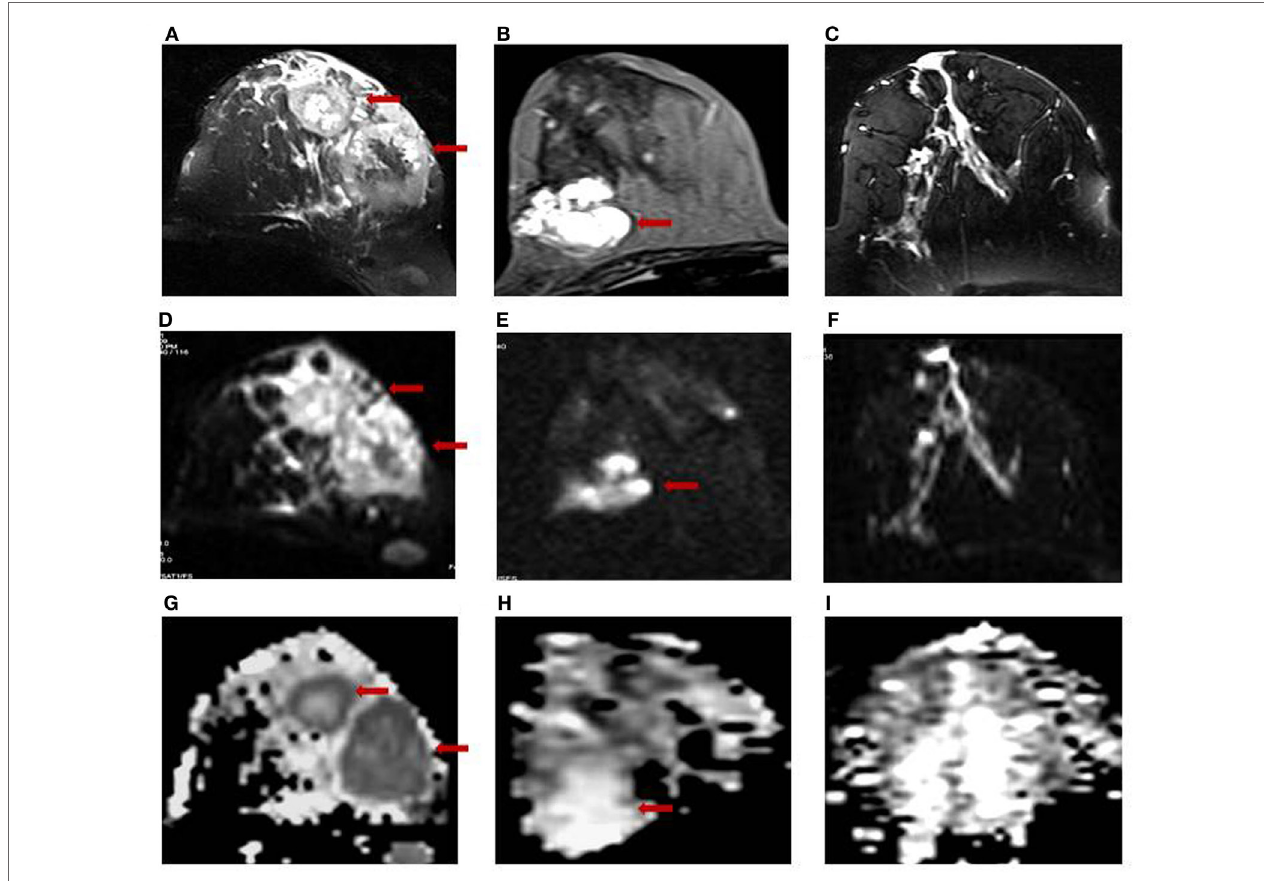
FigUre 1 | T2-weighted MR images of (a) a 28-year-old patient with infiltrating ductal carcinoma (IDC); (B) a 25-year-old patient with benign fibroadenoma; and (c) a 30-year-old volunteer with healthy breast tissue. The respective DW images are shown in (D–F) , while the ADC maps obtained are shown in (g–i)